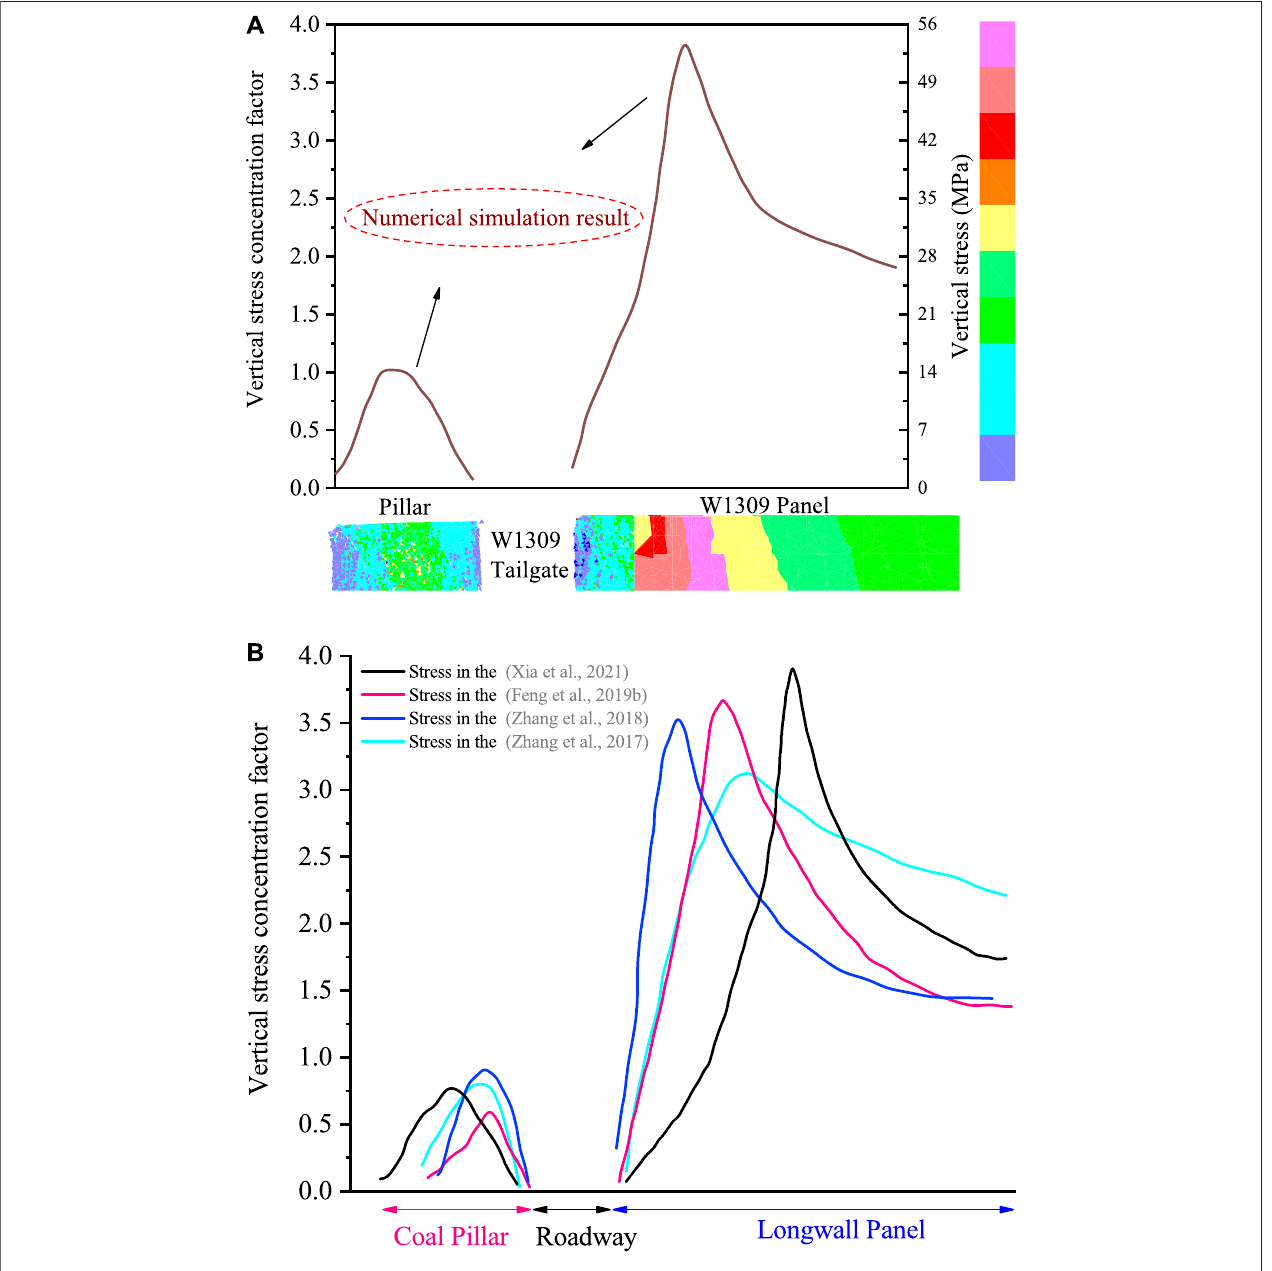
FIGURE9| Comparison ofverticalstressdistribution featuresaftertheworkingfacemining. (A) Thelawofverticalstressevolutionoftheroadwaysiscalculatedby the numerical simulation model; (B) The verticalstress concentration factor of the roadways in the references (Zhang et al., 2017; Zhang et al., 2018; Feng et al., 2019b; Xia et al.,